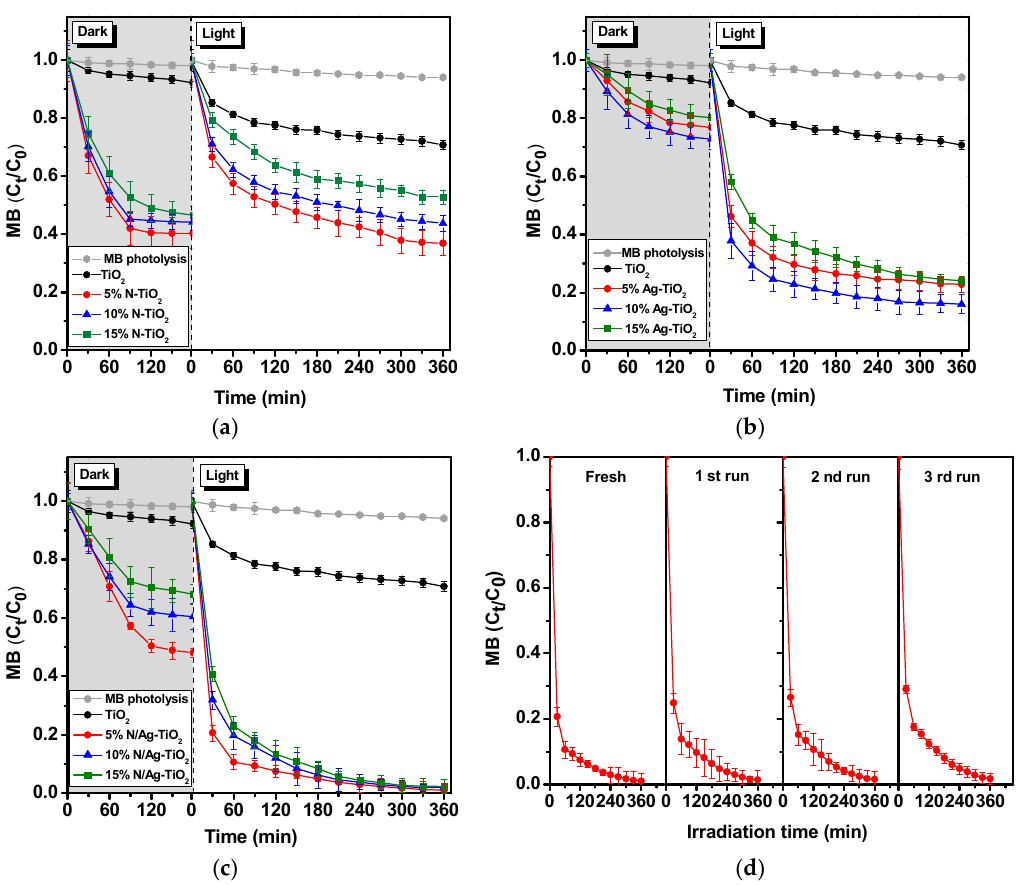
Figure 7. Adsorption and photocatalytic degradation of MB under the visible LED irradiation (16 W) by ( a ) N-TiO 2 , ( b ) Ag-TiO 2 , and ( c ) N/Ag-TiO 2, including the data for TiO 2 and MB photolysis (blank), and ( d ) recycled 5% N/Ag-TiO 2.